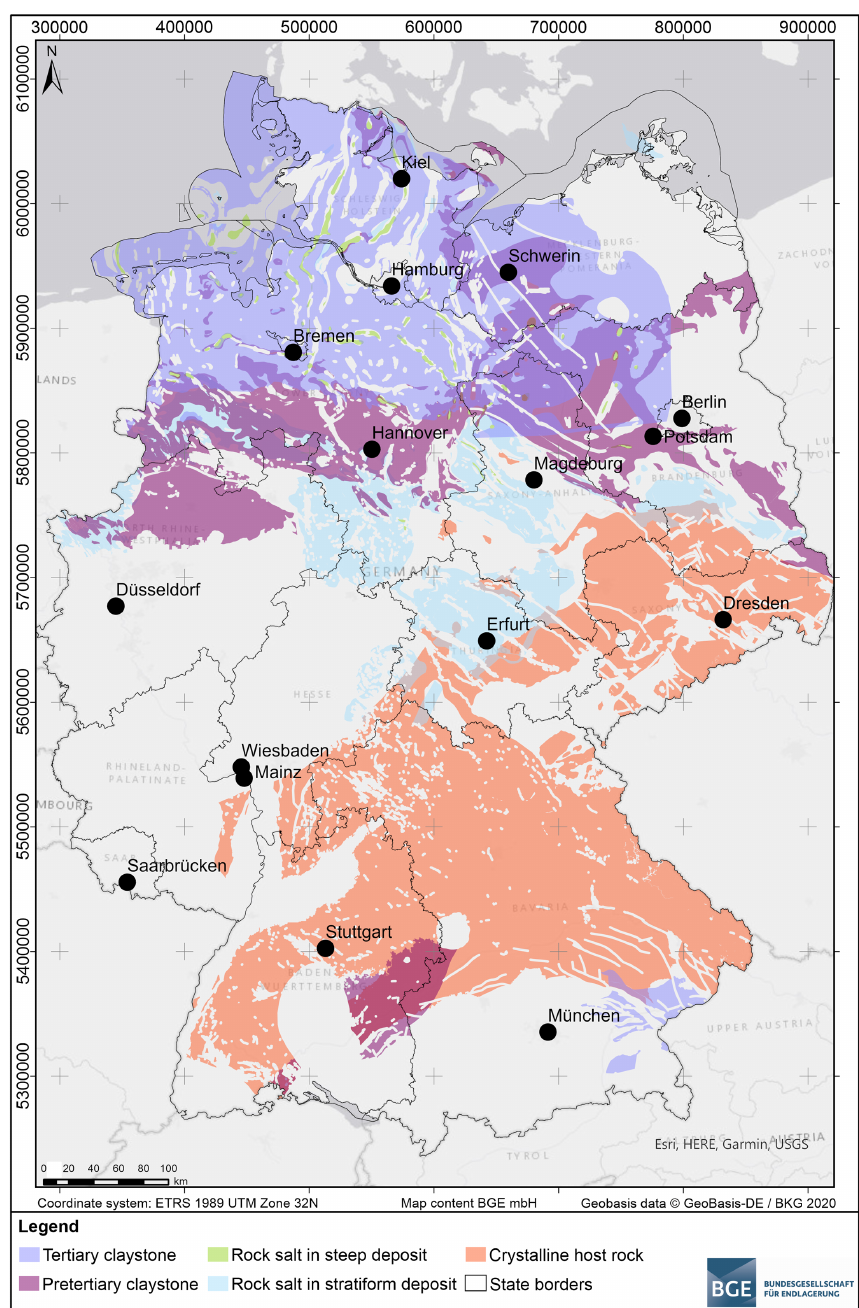
Figure 2. Map view of the sub-areas that were selected in Phase I, Step 1 of the site selection procedure (modified after BGE, 2020b).